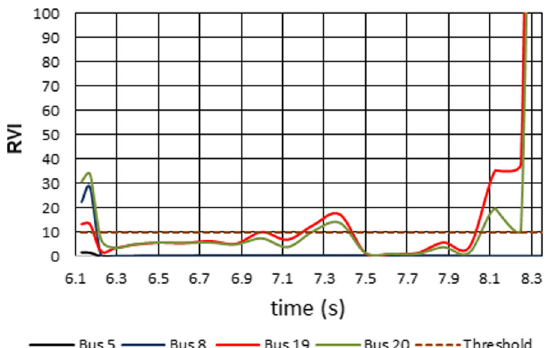
Fig. 20 RVI post